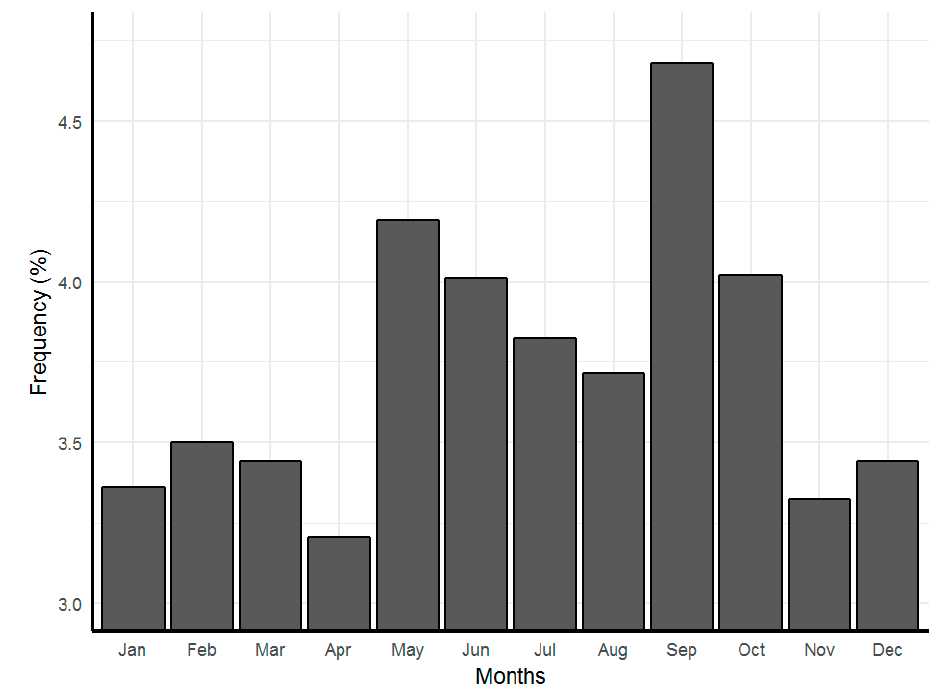
Figure 10. Monthly distribution of the average annual frequency of hourly precipitation.